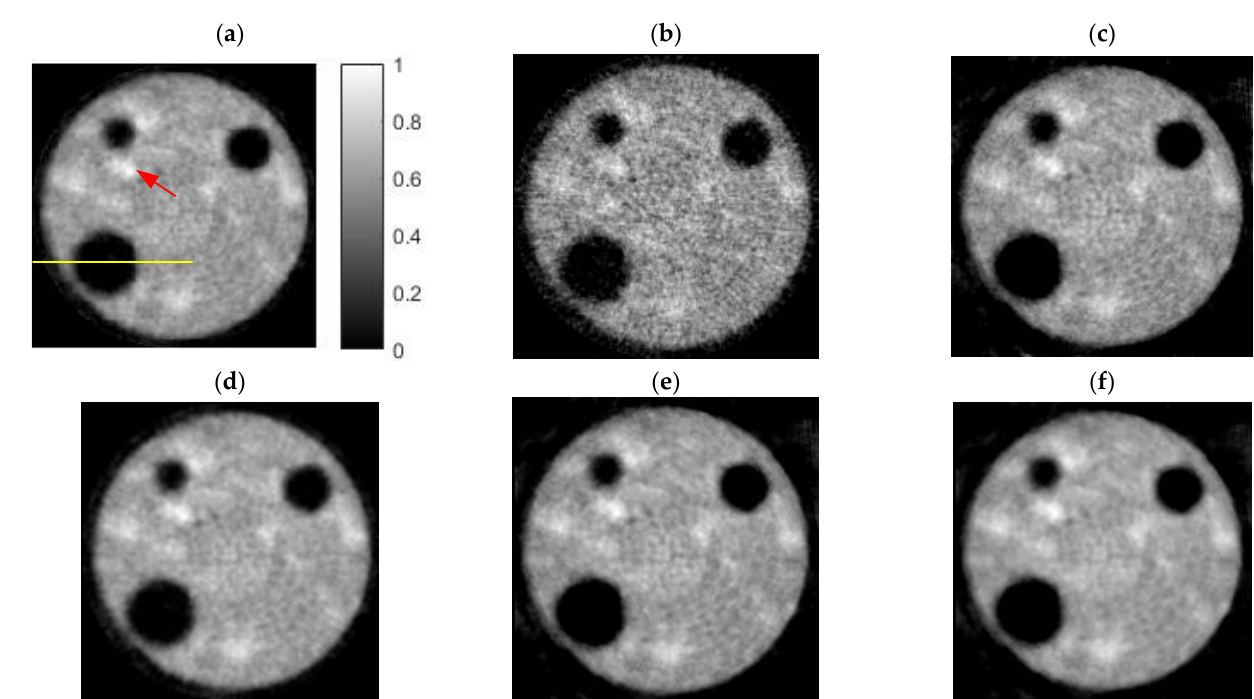
( b ) Figure 9. Neutron projection image and sinogram. ( a ) A neutron projection image of the nuclear fuel element from one angular view. ( b ) A sinogram of an axial layer. FBP algorithm is used to restore slice image from 180 projections, and the recon- structed image is used as a reference image to compare with the reconstructed results obtained by using other algorithms (FBP, SIRT, SIRT-TV, SIRT-WTDM, and SIRT- MWTDM) with 60 projections. The reconstructed reference image is shown in Figure 10a, and it is normalized. The